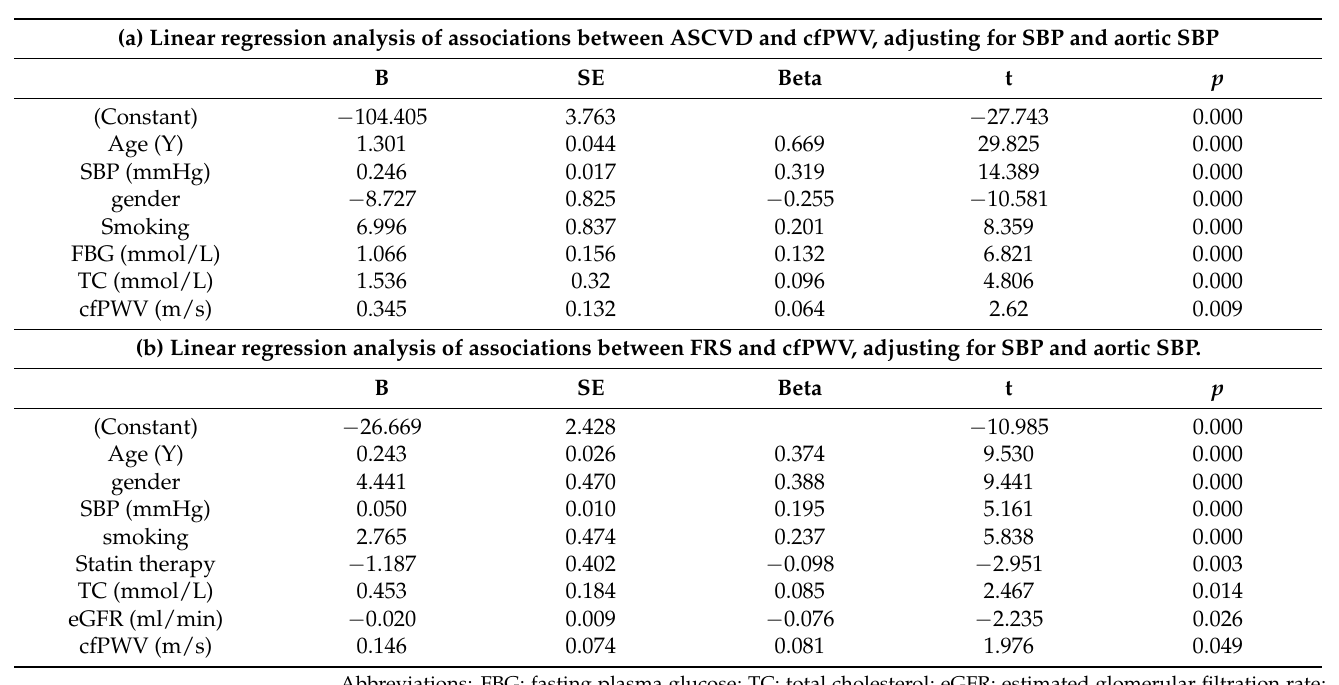
Table 4. Linear regression analysis of associations between cardiovascular risk scores and cfPWV.